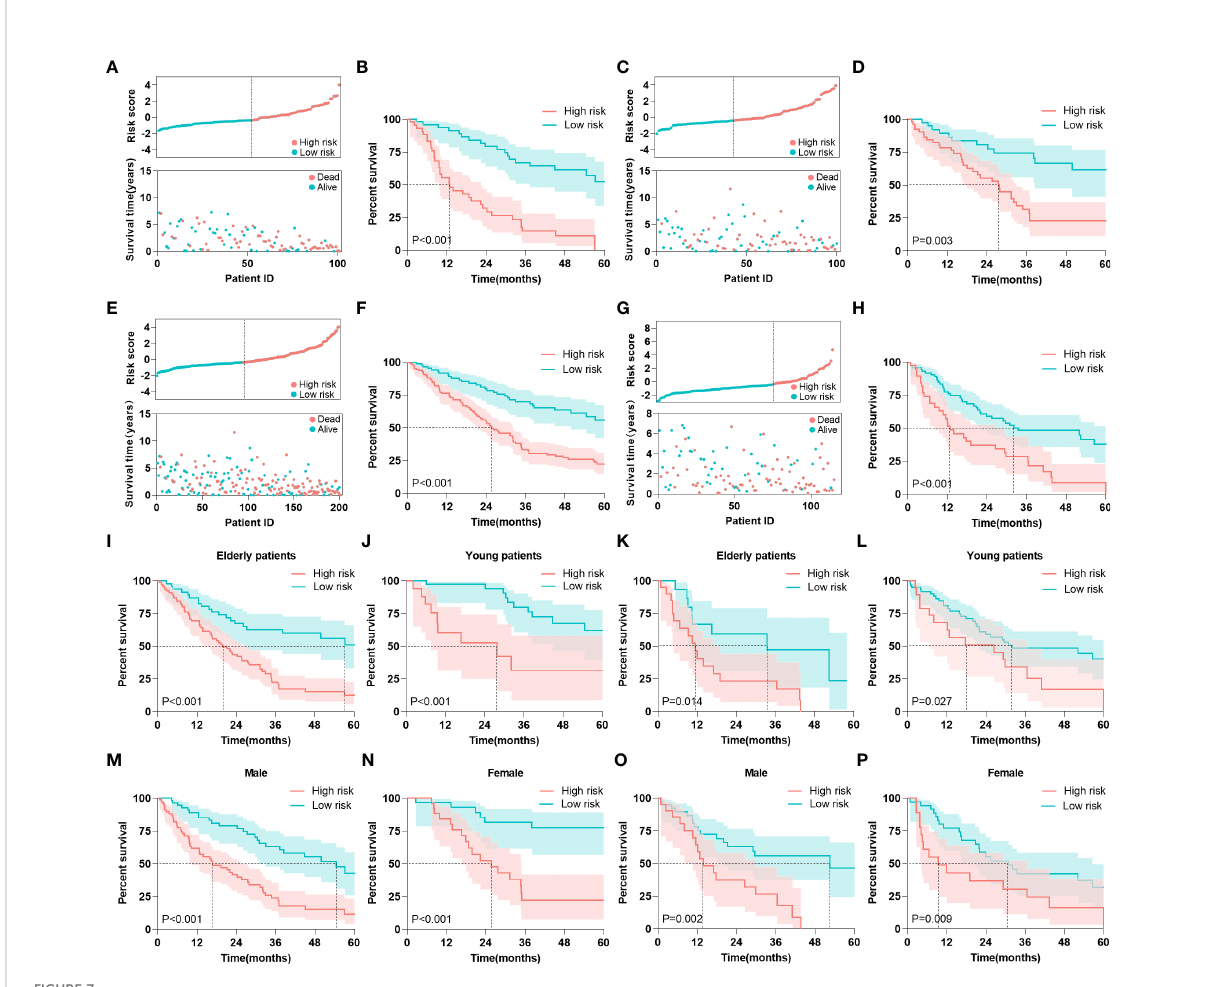
FIGURE 7 Risk strati fi cation. (A) Risk scores and survival times of patients were in the training cohort. (B) Kaplan-Meier analysis of MDS patients with different risk level in the training cohort. (C) Risk scores and survival times of patients were in the internal testing cohort. (D) Kaplan-Meier analysis of MDS patients with different risk level in the internal testing cohort. (E) Risk scores and survival times of patients were in the entire GEO cohort. (F) Kaplan-Meier analysis of MDS patients with different risk level in the entire GEO cohort. (G) Risk scores and survival times of patients were in the external validation cohort. (H) Kaplan-Meier analysis of MDS patients with different risk level in the external validation cohort. (I, J) Kaplan-Meier analysis of elderly and young patients with different risk level in the entire GEO cohort. (K, L) Kaplan-Meier analysis of elderly and young patients with different risk level in the external validation cohort. (M, N) Kaplan-Meier analysis of male and female patients with different risk level in the entire GEO cohort. (O, P) Kaplan-Meier analysis of male and female patients with different risk level in the external validation cohort. The log-rank test was used to compare survival rates between the two